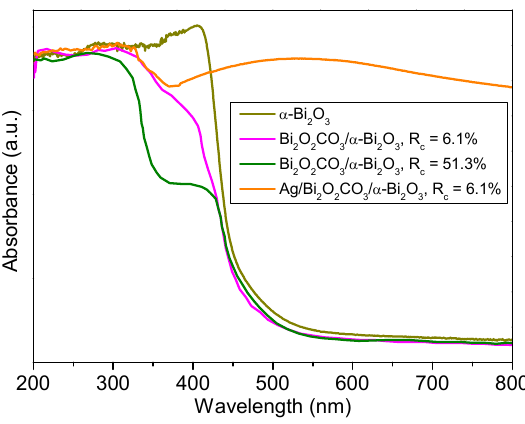
Figure 9. UV−vis diffuse reflectance spectra of α-Bi 2 O 3 , Bi 2 O 2 CO 3 /α-Bi 2 O 3 , and Ag/Bi 2 O 2 CO 3 /α-Bi 2 O 3 . Figure 9. UV − vis diffuse reflectance spectra of α -Bi 2 O 3 , Bi 2 O 2 CO 3 / α -Bi 2 O 3 , and Ag/Bi 2 O 2 CO 3 / α -Bi 2 O 3